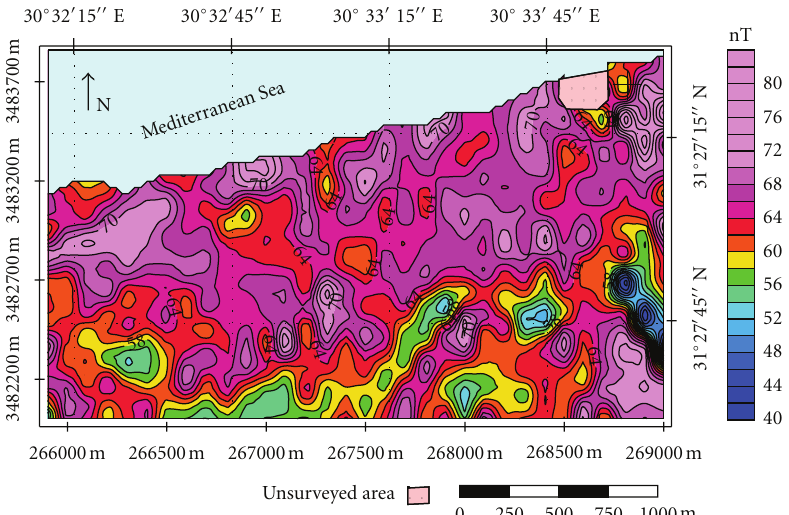
Figure 5: Filled colour contour map of the regional component of magnetic-field intensity of Koam Mashaal area, East Rosetta, Mediterranean Sea Coast, Northern Egypt at an average depth ( h ) of 239.6 m, contour interval = 2nT.